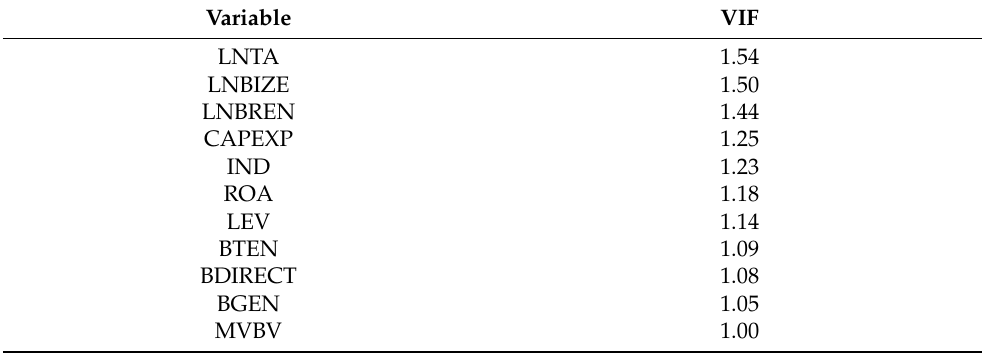
Table 3. Variance inflation factor.